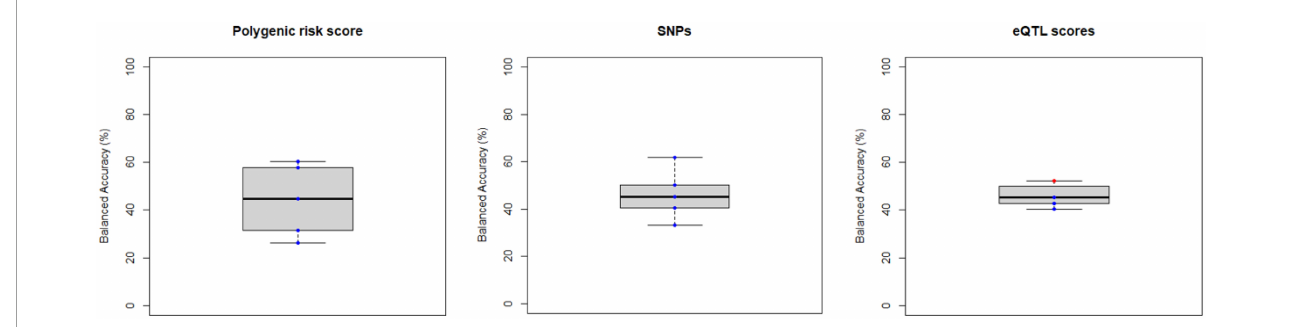
FIGURE5 Balanced accuracy across bootstrapped samples for each model trained with the polygenic risk score, the list of psychosis-associated single nucleotide polymorphism (SNPs) or with the list of psychosis-associated genes for which an expression quantitative trait loci (eQTL) score was extracted. Dots represent the balanced accuracy value in each of the 5 bootstrapped samples and are red colored if the balanced accuracy is statistically significant (i.e., p < 0.05) or blue colored if it is not (i.e., p > 0.05). The statistical significance of the balanced accuracy in each bootstrapped sample was evaluated through permutation testing.